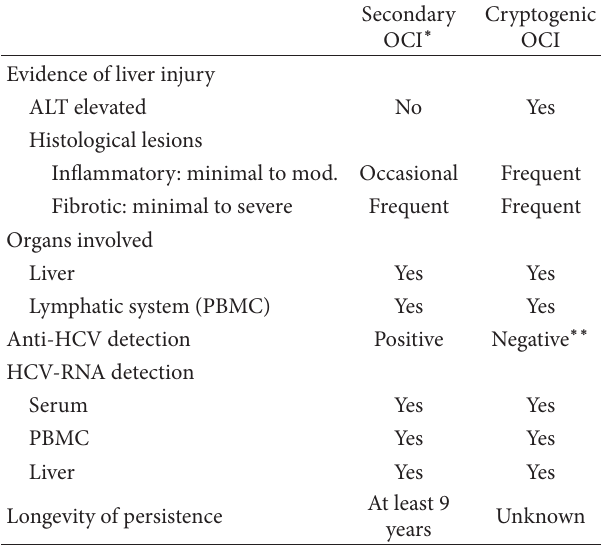
Secondary Cryptogenic OCI ∗ OCI